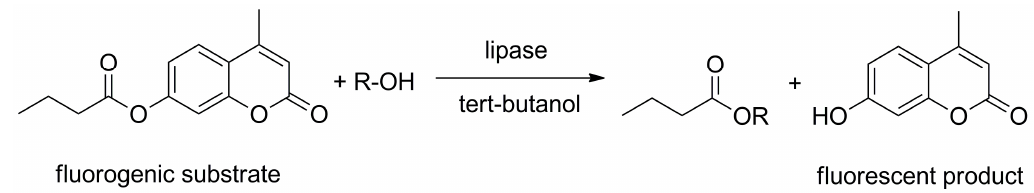
Figure 6. The principle of the colorimetric assay based on indoxyl acetate hydrolysis by lipase which can be inhibited by pesticides like paraoxon.